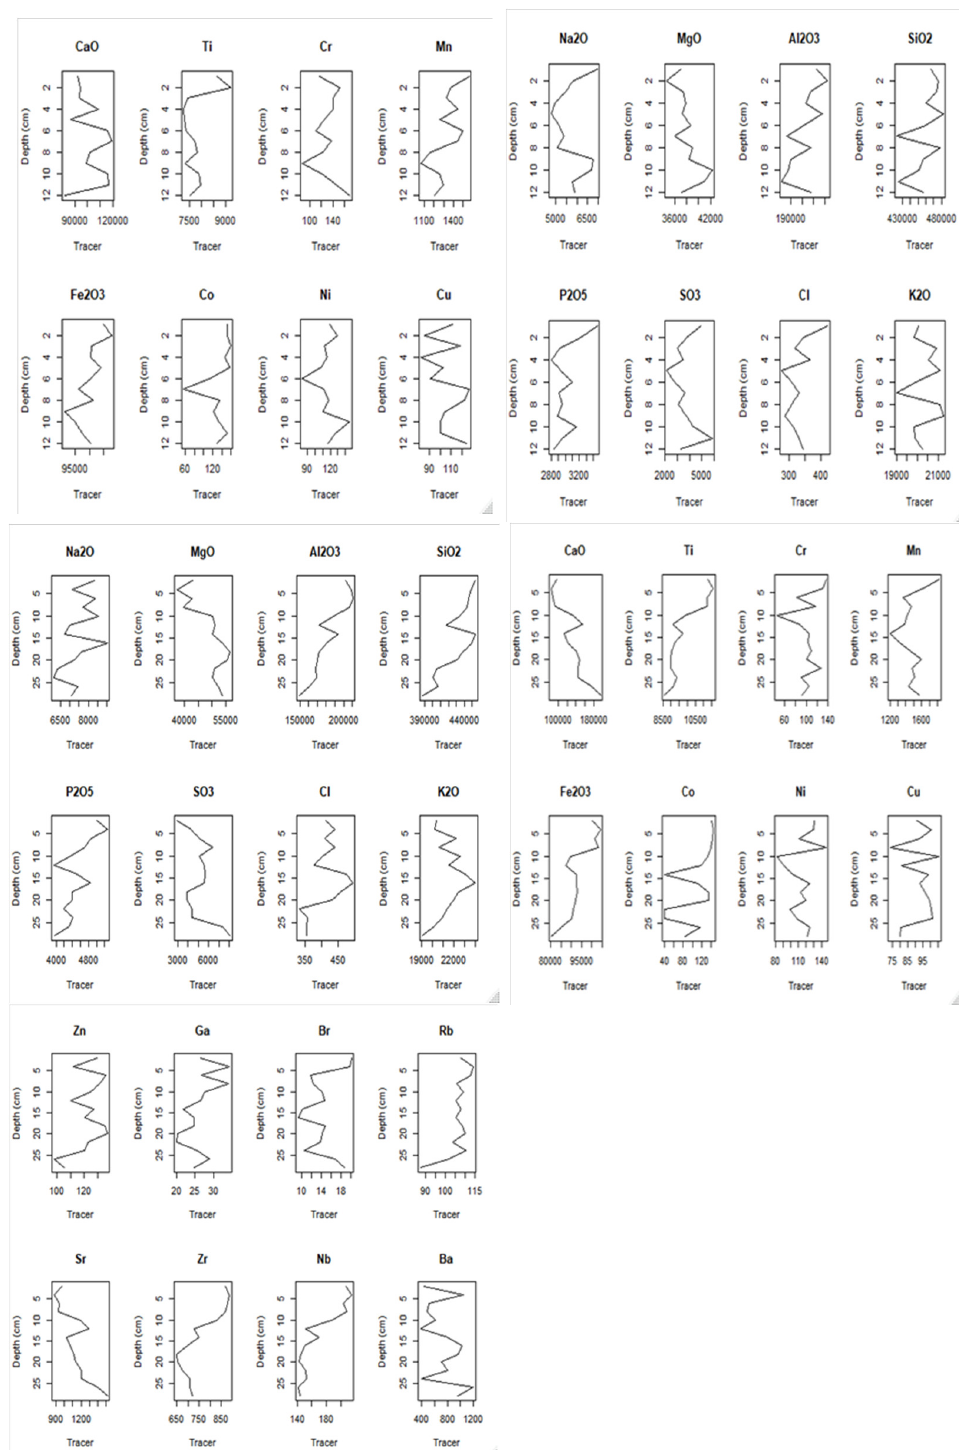
Figure A4. Geochemical depth profiles of core AC1, AC2 and AC3 respectively. Concentration in ppm.